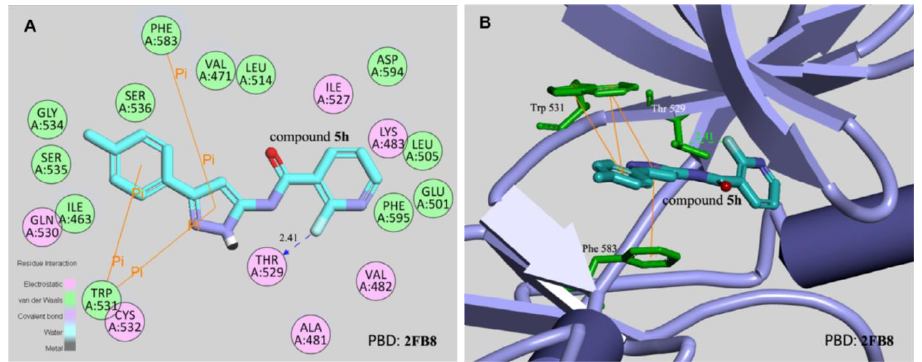
Figure 72. Putative binding interactions of compound 66 with V600E-B-RAF crystal structure [79]. ( A ) 2D interactions; ( B ) 3D